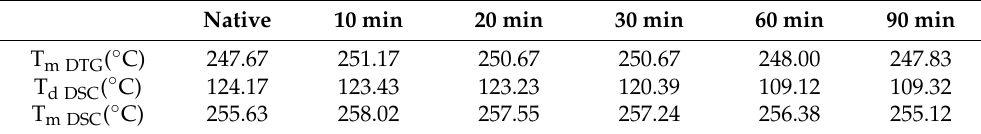
Table 3. Thermal analysis of native SBP and its ultrasonic degradation